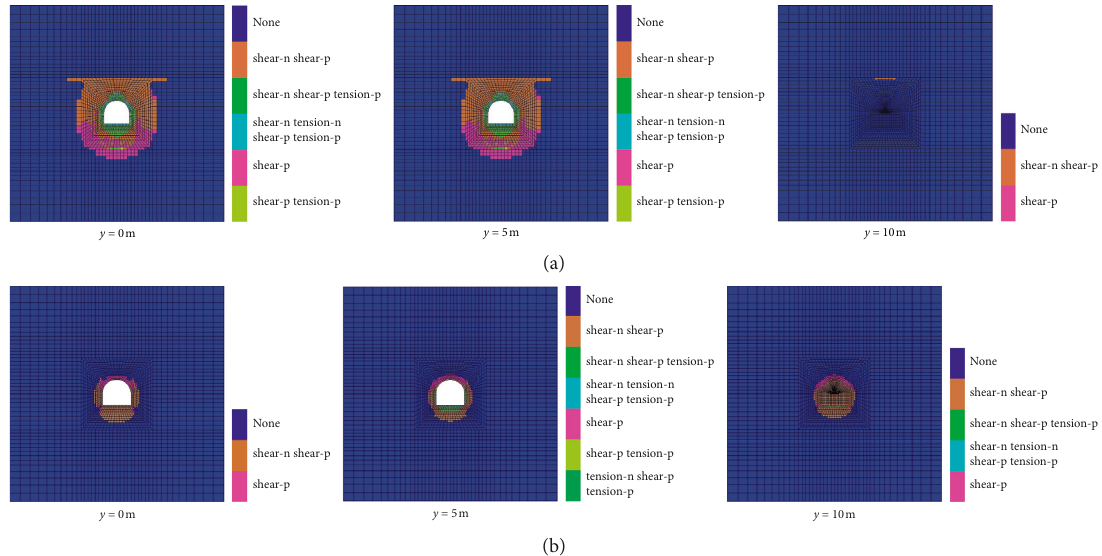
Figure 8: Damage mechanism of surrounding rocks of the tunnel floor after excavation: (a) plan A; (b) plan